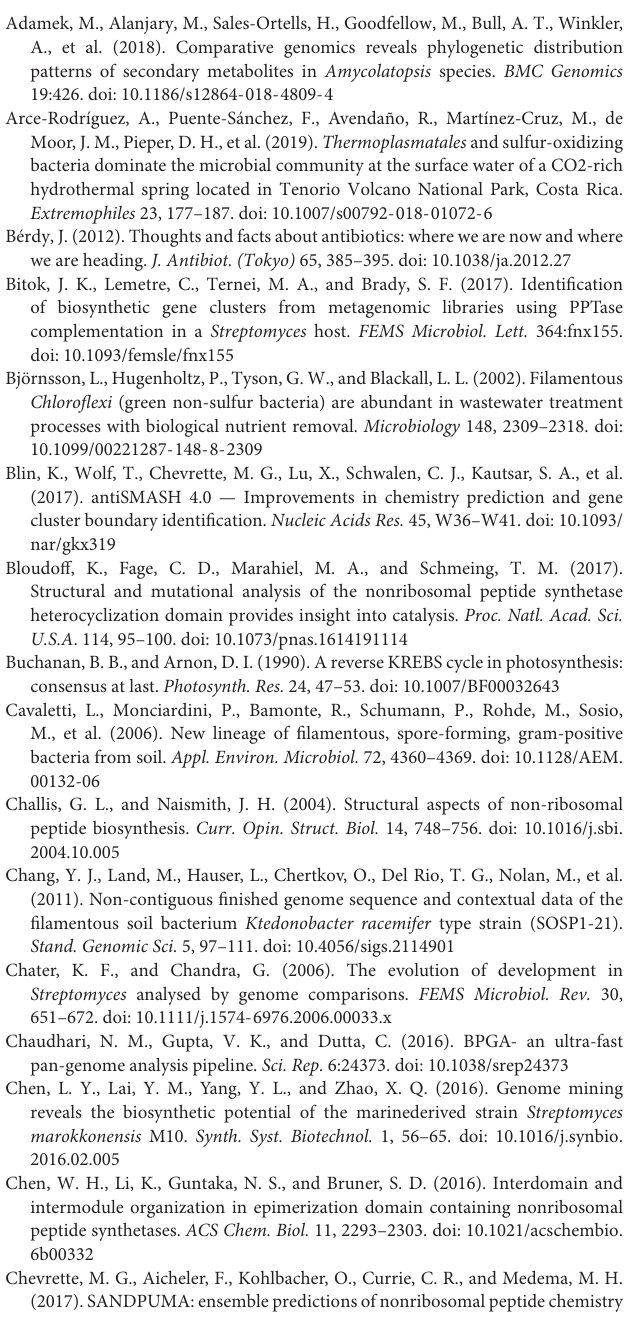
TABLE S3 | Similarities of multiple 16S ribosomal RNA operons within the nine studied Ktedonobacteria strains. TABLE S4 | cox gene (A) and KEGG pathway (B) analysis of the Ktedonobacteria strains. TABLE S5 | Pan-genome analysis of the Ktedonobacteria genomes (A) , D. aurantiacus S27 T and Ktedonobacterales bacterium Uno16 contig1 (B) , and